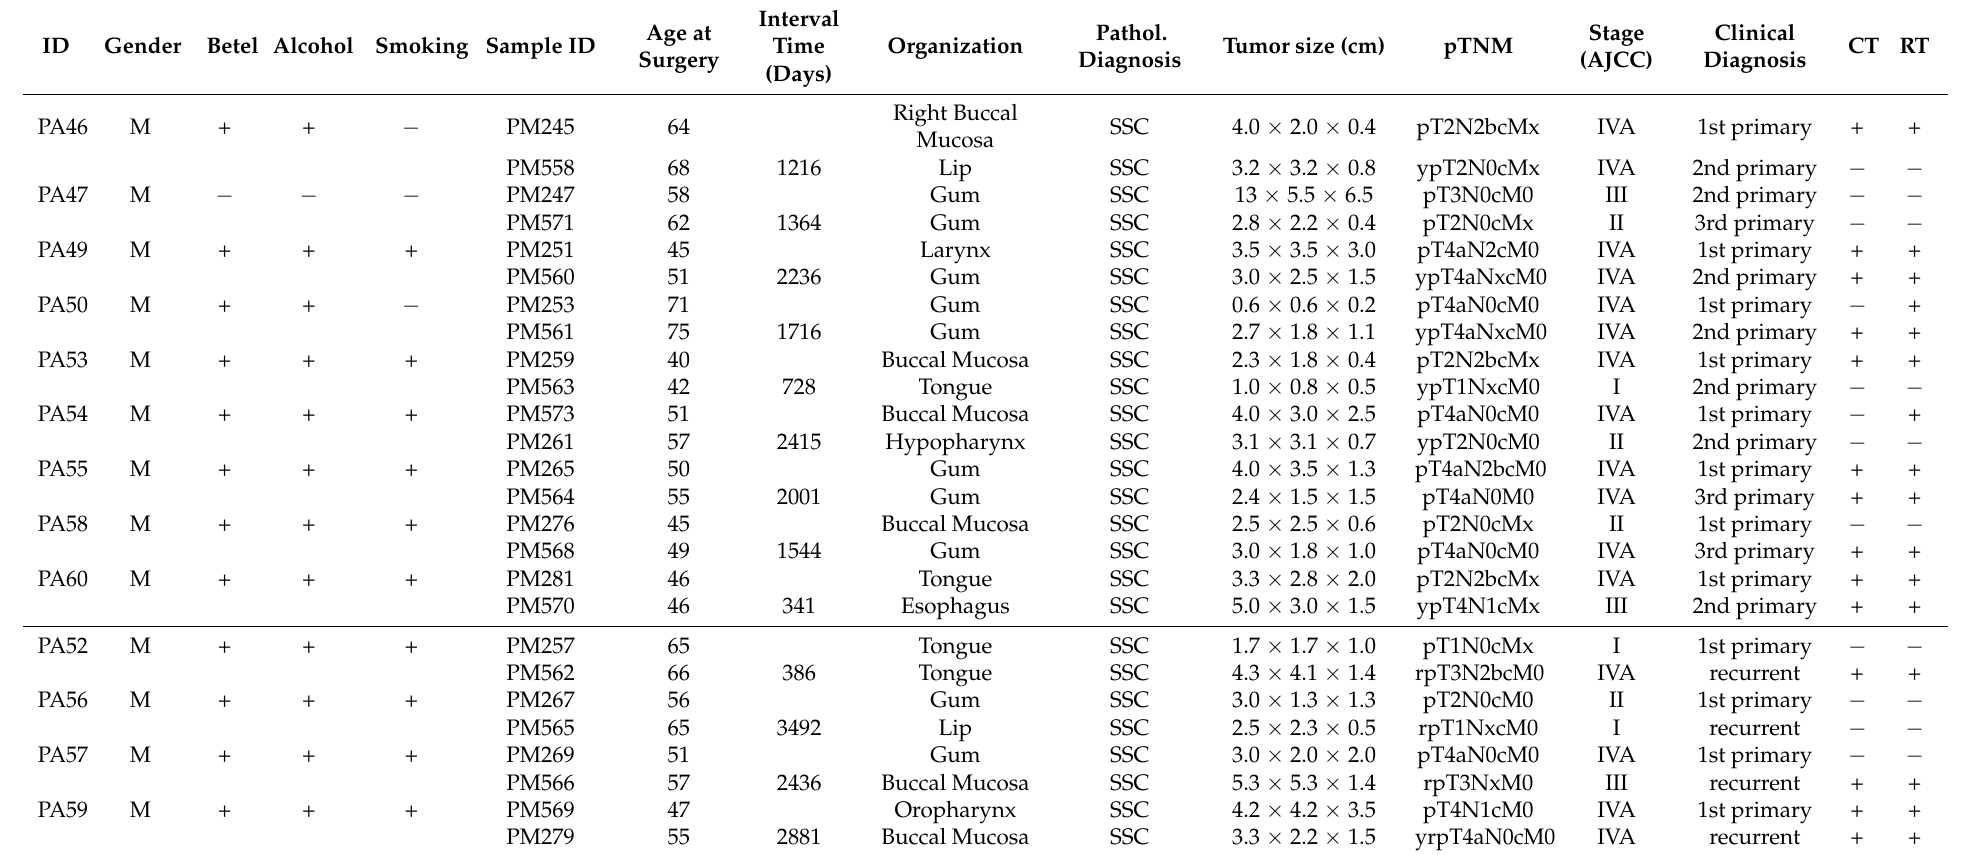
Table 1. Description and clinical information of patients included in the